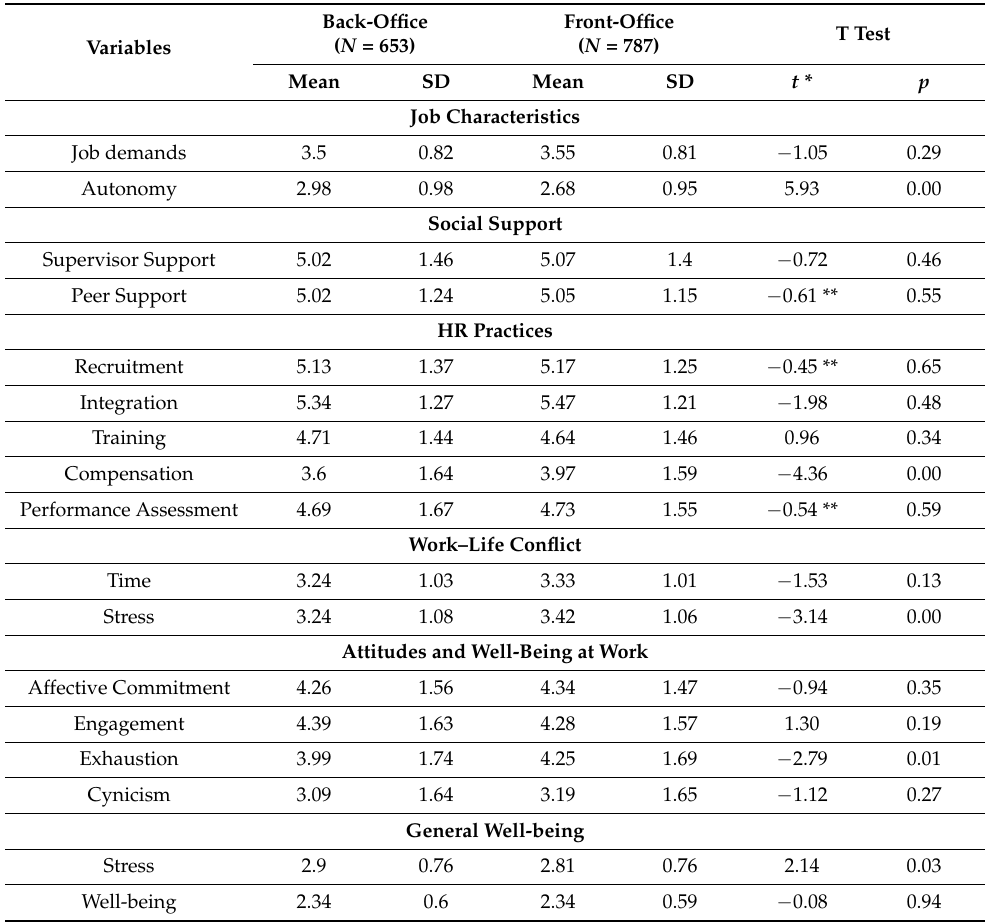
Table 2. Mean, Standard Deviation, and Student t -test of the Variables under Study, according to